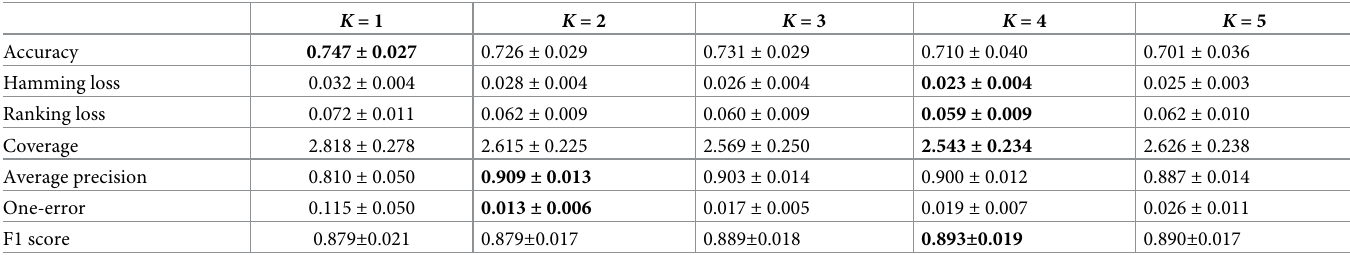
Table 4. Cross-validation results of the resistance variant for multiple fault location